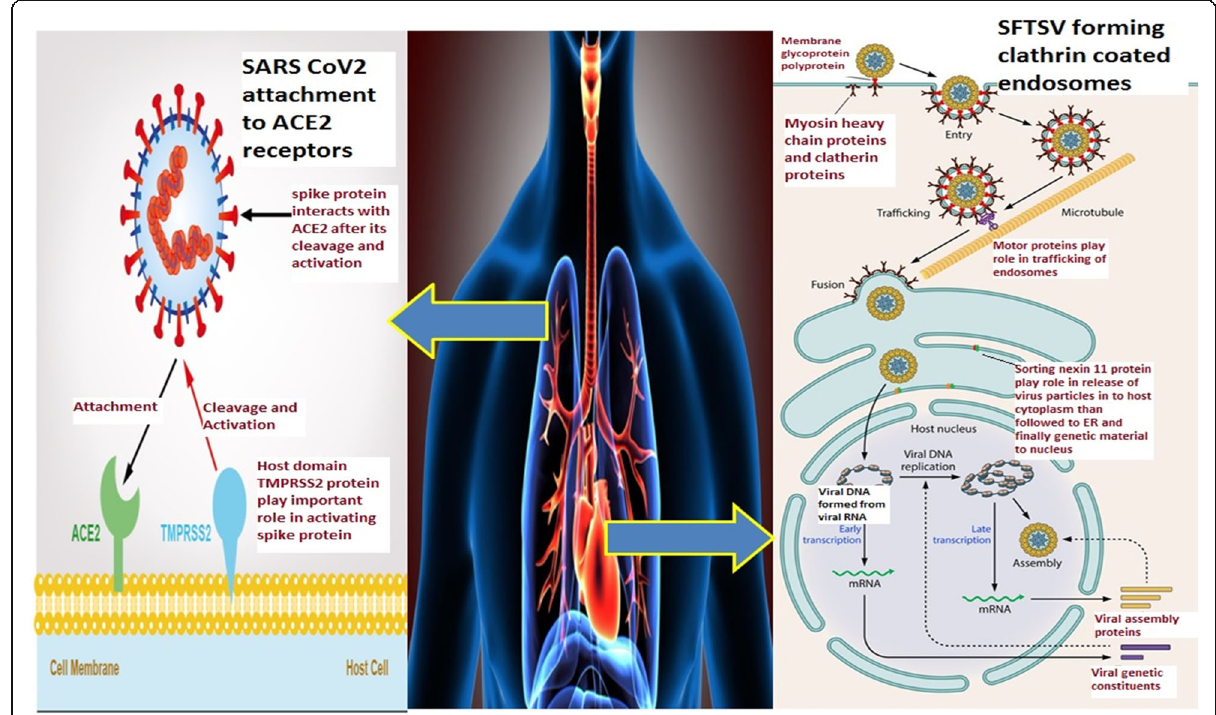
Fig. 1 Basic pathology of viruses (host-virus interaction): SARS-CoV2 attachment with ACE2 receptors of endothelial cells and SFTSV clustered in endosomes with the help of clathrin-coated